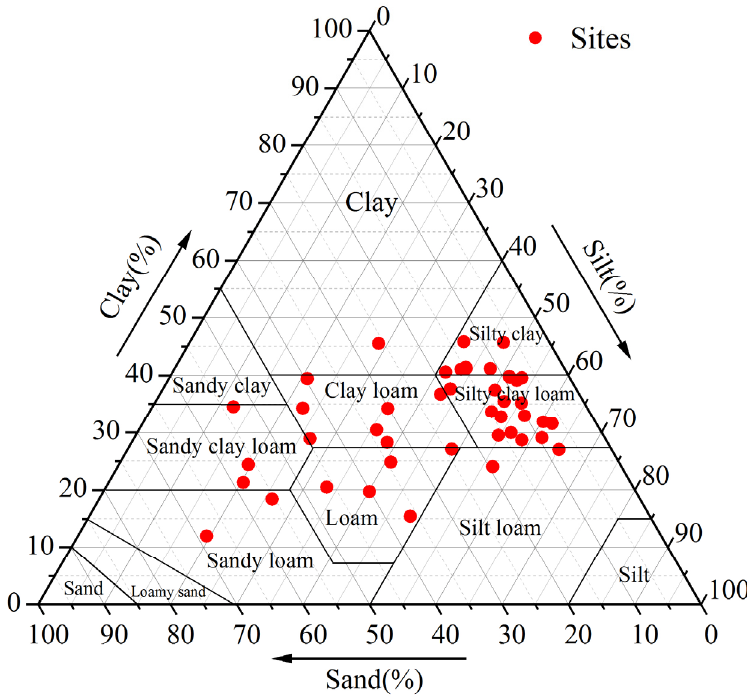
Figure 2. Soil texture triangle of the sampling sites.